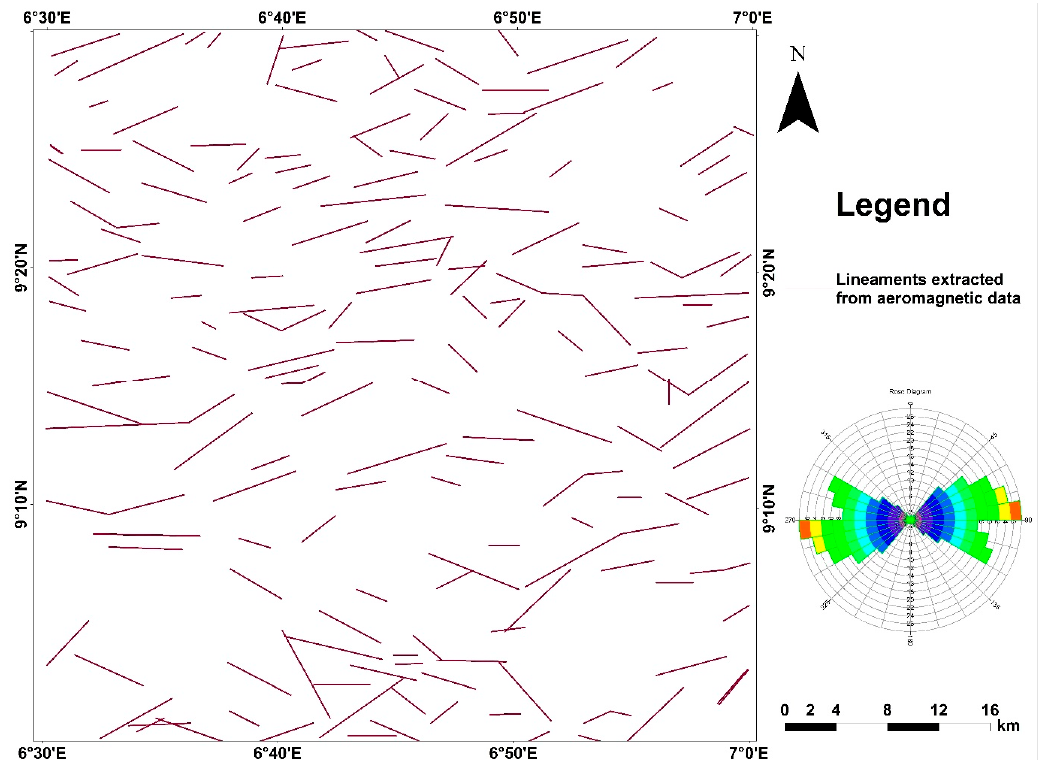
Figure 5. Magnetic lineaments extracted from aeromagnetic data of Paiko Sheet 185 North Central Nigeria. Lineament map is a composite of lineaments extracted from first vertical, horizontal and tilt derivatives of the aeromagnetic data. Inset: Rosette diagram showing principal orientations of lineaments in the ENE–WSW direction.